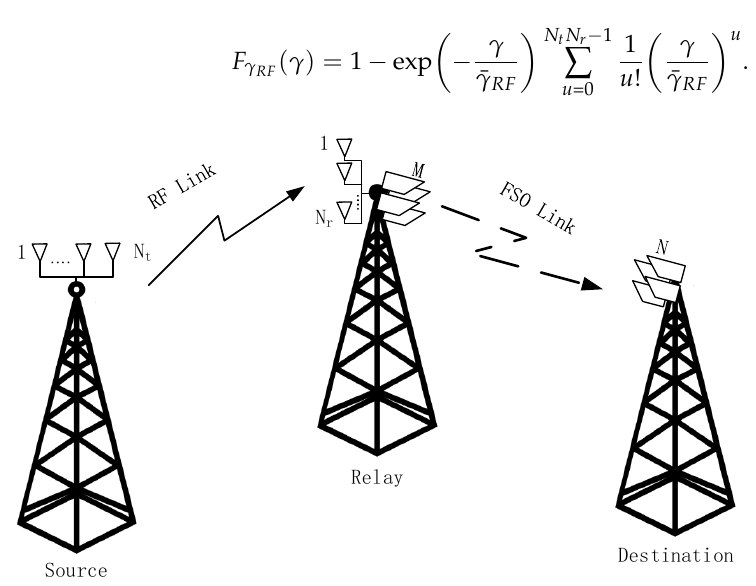
Figure 1. Block diagram of the MIMO mixed RF/FSO relaying